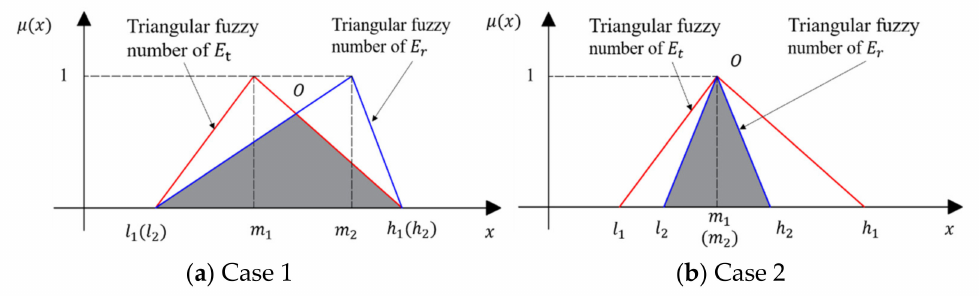
Figure 4. Special cases for FTNs when calculating the expert’s relative degree of